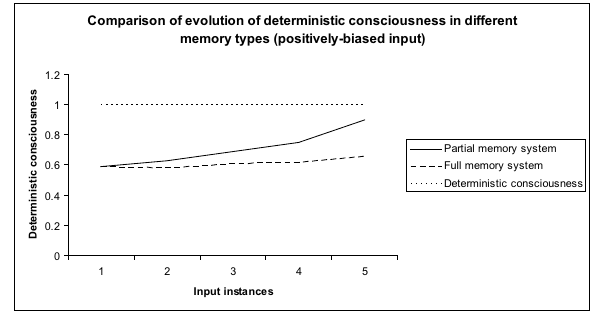
Fig. 33. Comparison of deterministic consciousness with memory (+biased input).